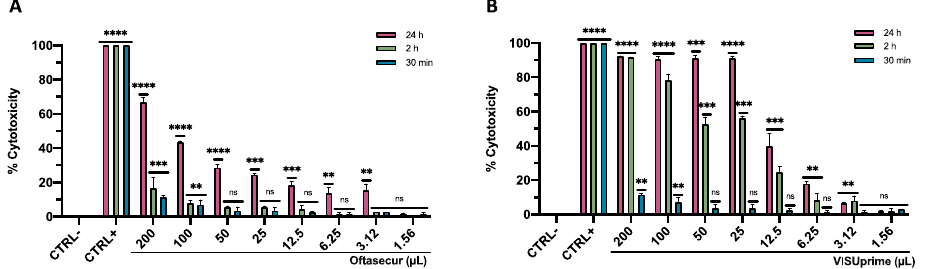
Figure 1. ( A ) Oftasecur cytotoxicity on Vero CCL-81 cell line after 0.5 (***: p -value = 0.0012, **: p - value = 0.0021, ns: p -value > 0.88), 2 (***: p -value < 0.0010, **: p -value < 0.0018, ns: p -value > 0.76)